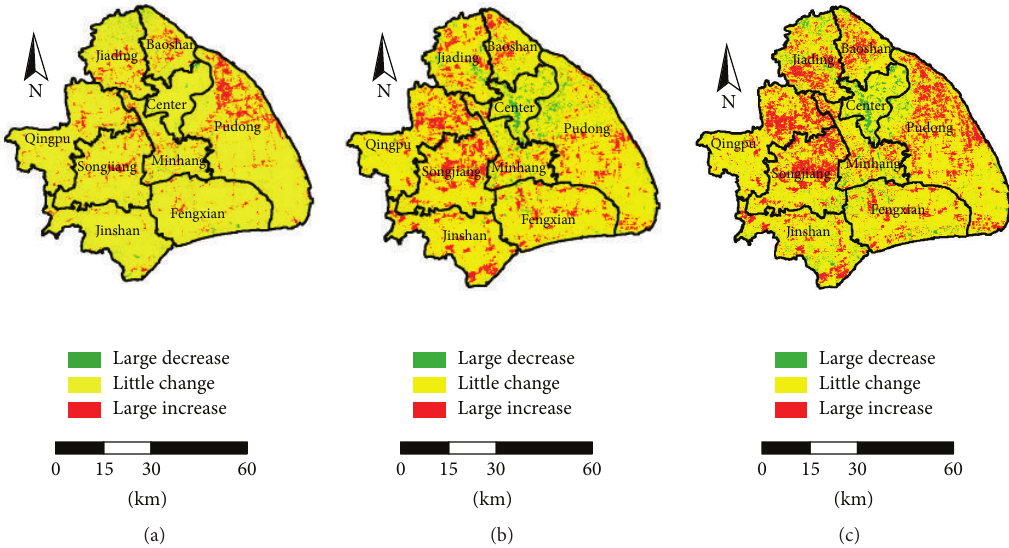
Figure 4: The changes in LST in Shanghai: (a) from 1989 to 2000, (b) from 2000 to 2013, and (c) from 1989 to 2013.